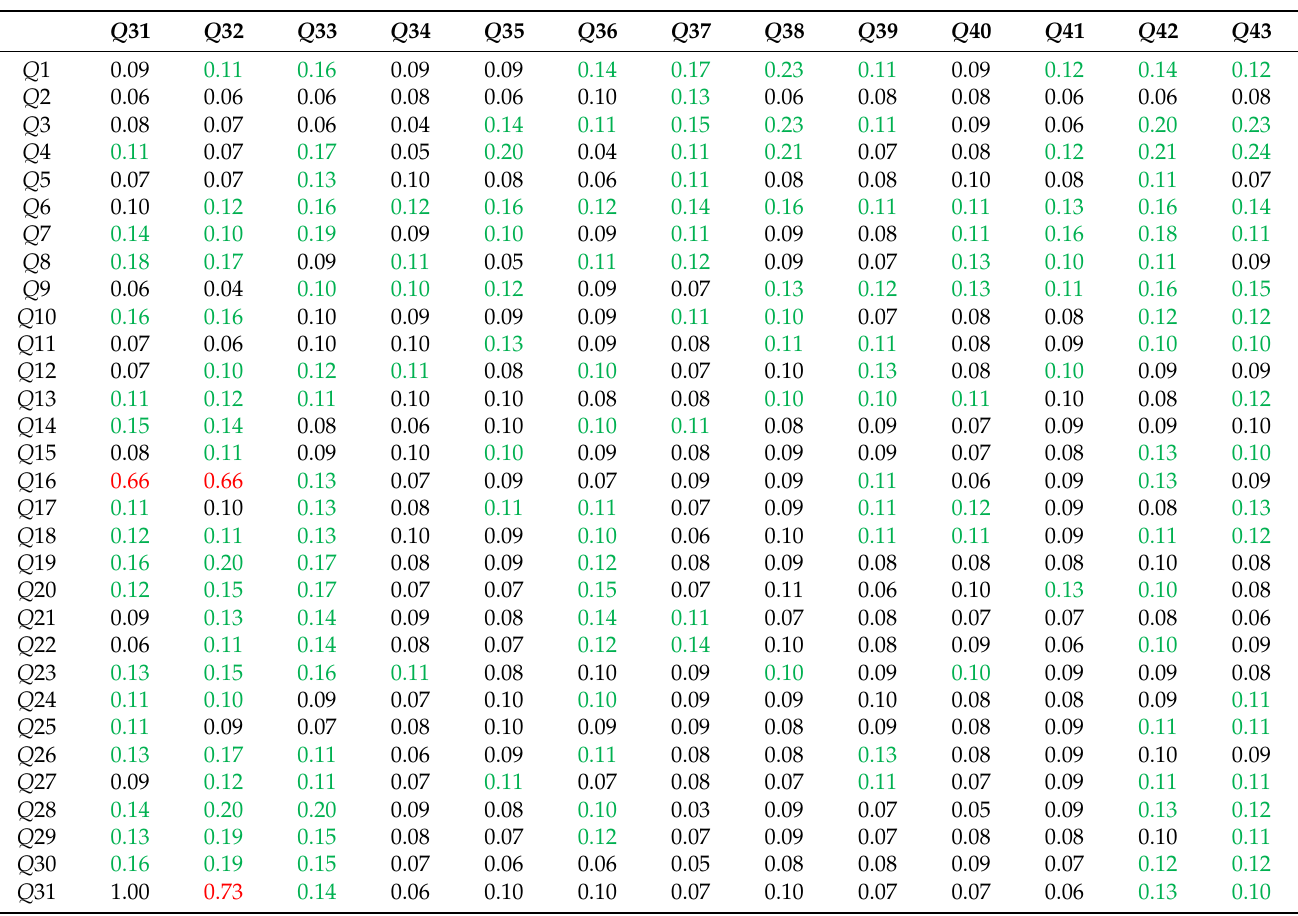
Table A4. The values of the Cramer’s V coefficient for questions Q 31– Q 43 (questions numbers ( Q ) according to the Appendix